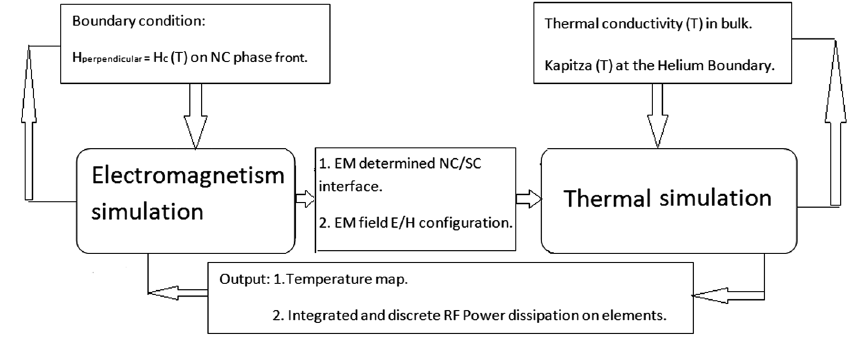
11. Flowchart of electromagnetic and temperature simulations. It is used to correct the size of the normal conducting zone and to estimate the rf loss. The flowchart shows a “ big ” iteration with two “ small ” iterations. Results of electromagnetic and thermal simulations are detailed in Secs. II A and II B in Figs. 6 and